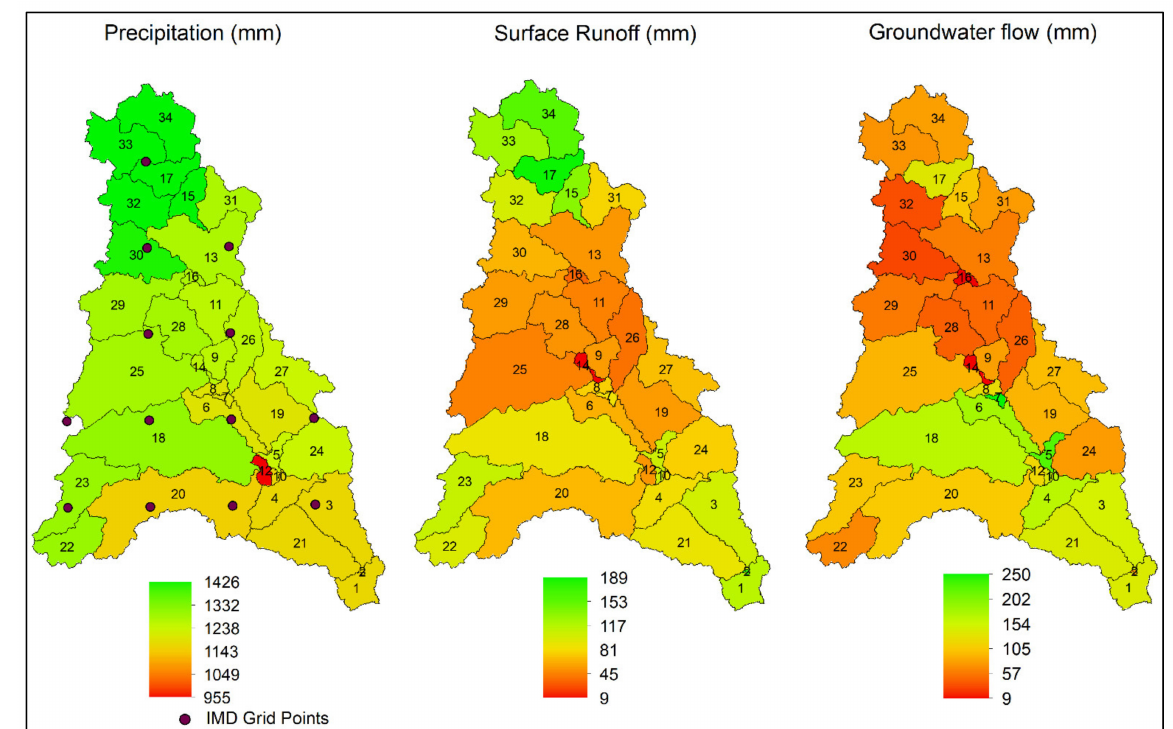
Figure 9. Spatial distribution of average annual precipitation, surface runoff and groundwater flow over the Nagavali river basin for the period of 24 years